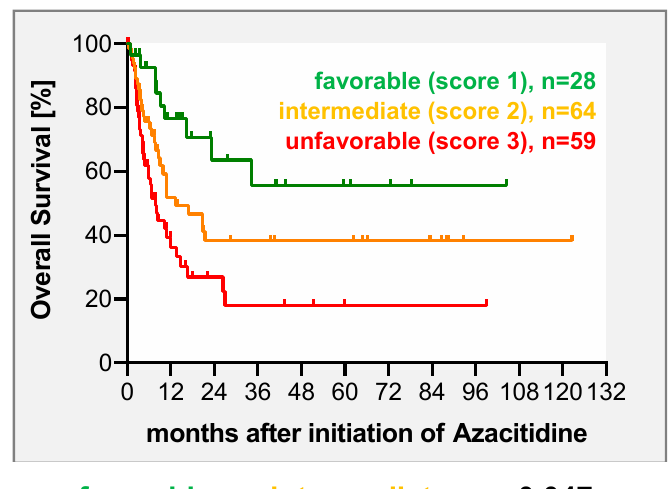
Figure 2. Overall survival (OS) after treatment with azacitidine ± DLI in 151 patients based on a scoring system including relapse type and time between allo-HSCT and diagnosis of relapse. One point was assigned for molecular relapse, while two points were given for diagnosis of hematologic relapse. An interval between transplant and relapse of ≥ 6 months was assigned with zero points, while for relapse within the first 6 months after transplant one point was given. As such, the model enables a stratification of patients into three distinct risk categories (favorable = 1 point, intermediate = 2 points, unfavorable = 3 points). Table 4. Two-year overall survival and response rate of 151 patients with MDS, sAML, and de novo AML treated with azacitidine ± DLI for relapse after allo-HSCT according to the proposed scoring system.